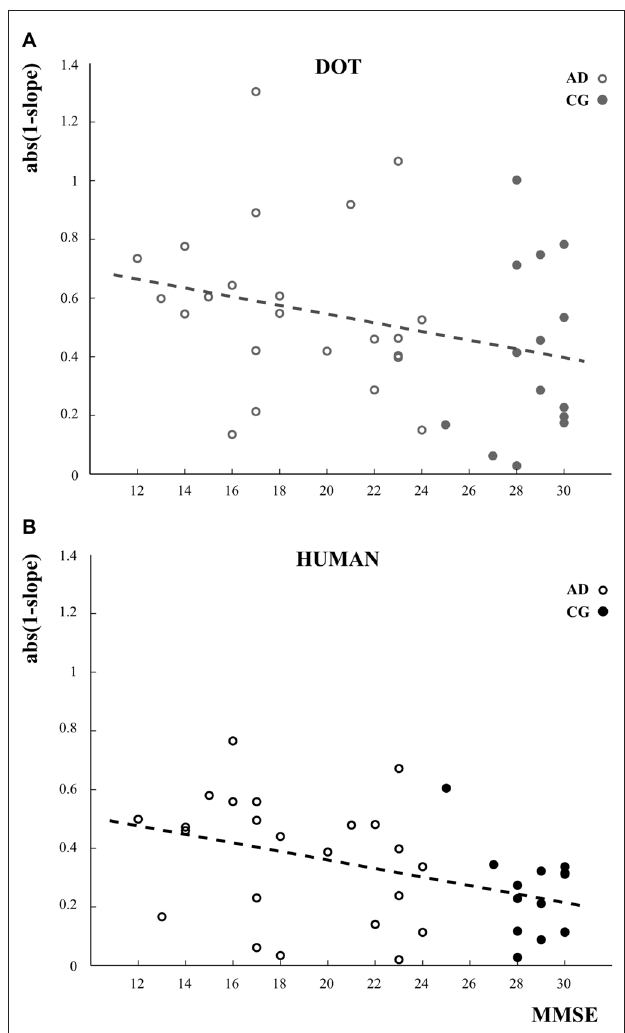
FIGURE 5 | Linear relationships between the imitation index and the cognitive status assessed using the mini mental state examination (MMSE) scores for the dot condition (A, gray circles) and the human demonstrator condition (B, black circles). Open and closed circles refer to the data of AD patients and the control participants (CG), respectively. The imitation index is here defined as the absolute difference between the slope of the perfect imitation line (slope = 1) and the slope of the linear regression model applied to describe the relationship between participants’ and stimulus velocities. The greater the difference, the worse the imitation